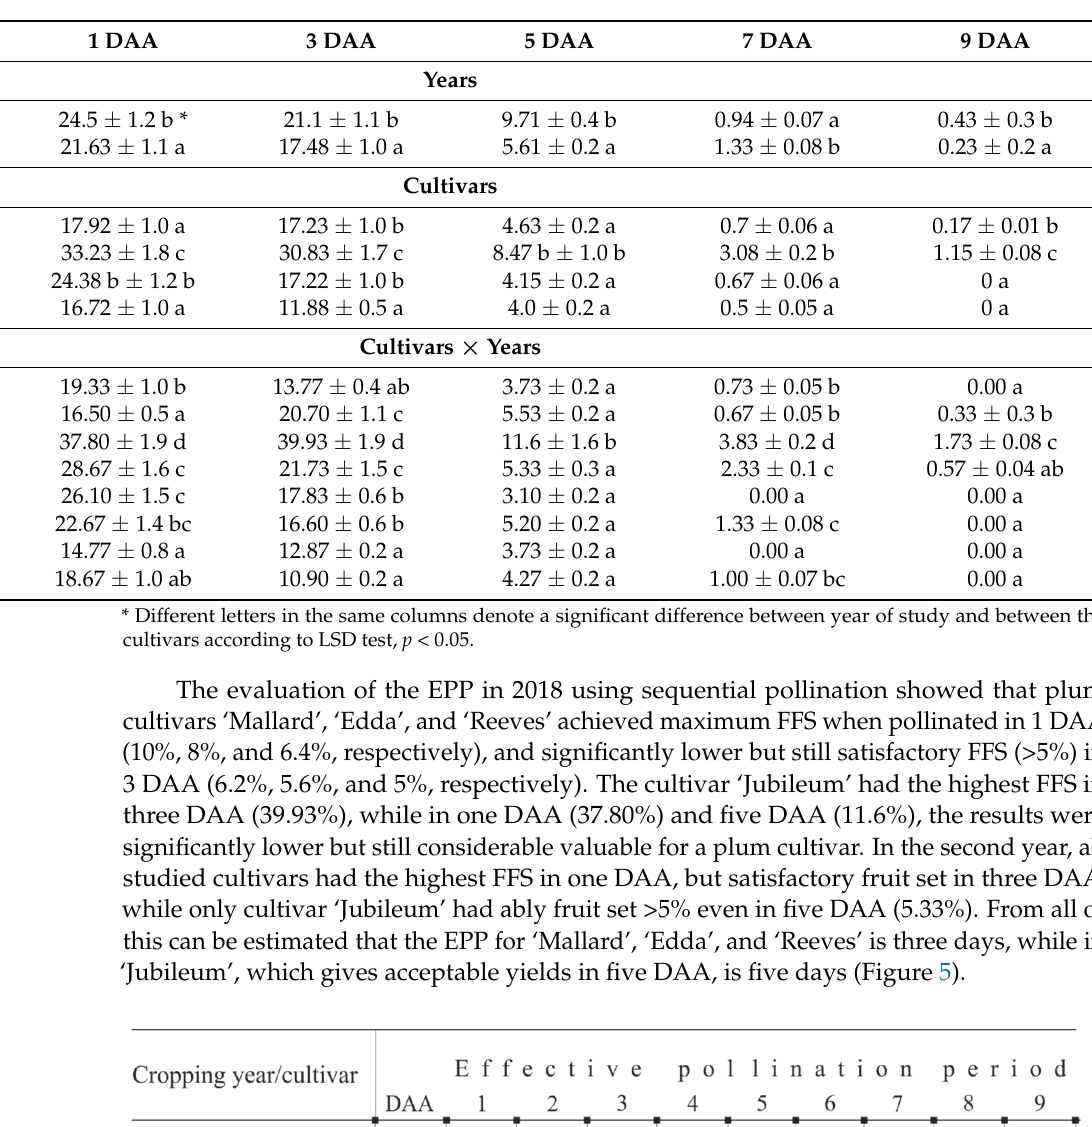
Table 1. Average fruit set ± standard deviations of five replications in four plum cultivars for 2018 and 2019 in different treatments.